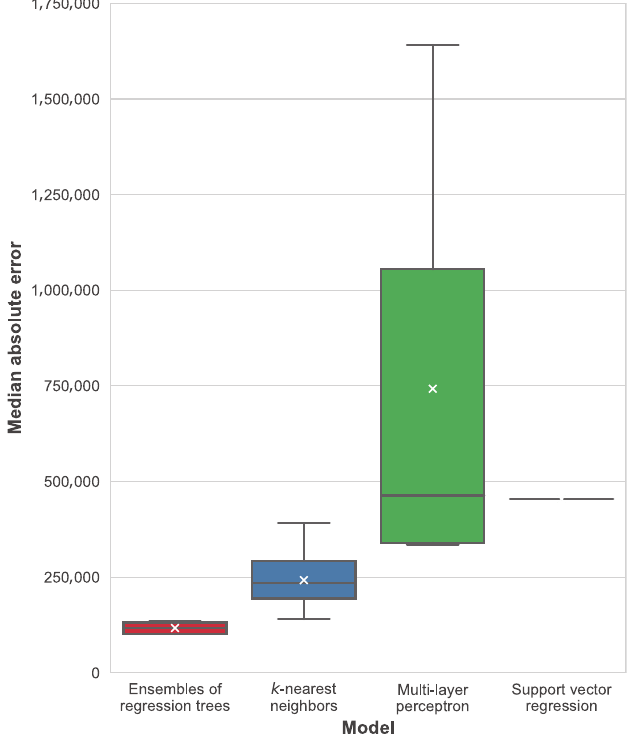
Figure 9. Boxplot of the distribution of median average errors per machine learning technique.